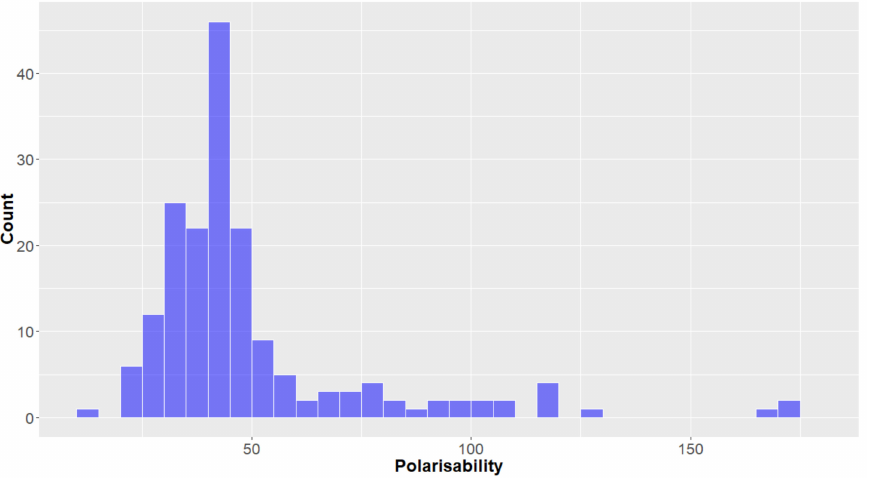
Figure 13. The statistical distribution of the polarisability of all analysed compounds. Total number of compounds =